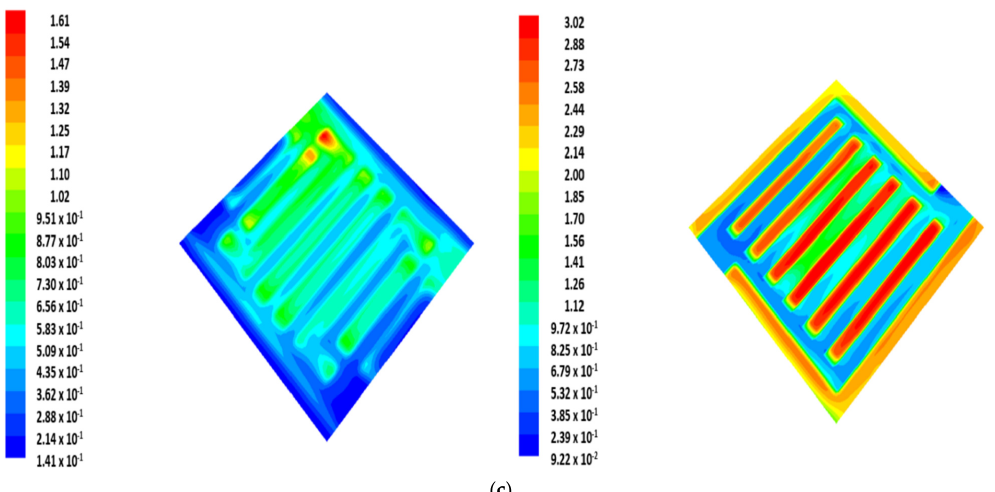
Figure 7. Contour of small-scale 7-channel model: ( a ) pressure distribution (Pa); ( b ) reactant distribution (kg/m 3 s); and ( c ) water content distribution ( θ ).